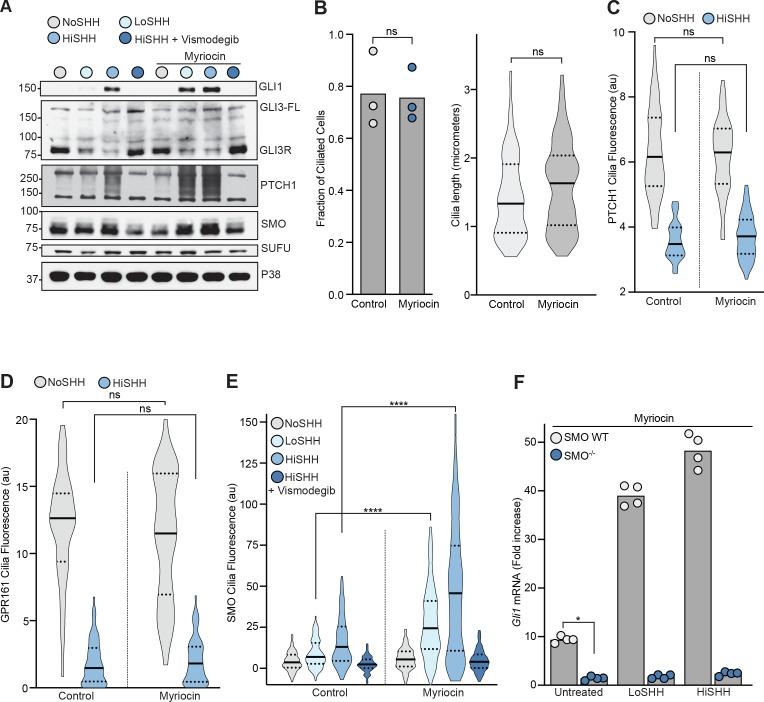
The effect of myriocin treatment on the abundances of hedgehog pathway components and on ciliary protein trafficking.(A) Western Blot showing levels of HH signaling proteins (SMO, SUFU and GLI3-FL/GLI3R) and HH target genes (GLI1 and PTCH1) after treatment with myriocin and either LoSHH (2.5 nM), HiSHH (25 nM) or HiSHH with Vismodegib (2.5 µM). (B) Ciliation frequency (left) of cells after myriocin treatment, calculated as the number of cilia over the number of nuclei. Each point represents the ciliation frequency (derived from >30 cells) in a different imaging field. The cilia length distribution (from 100 cells) is shown on the right. (C and D) Violin plots showing the lack of an effect of myriocin on levels of PTCH1 (C, n > 50 cilia per condition) or GPR161-YFP (D, n > 35 cilia per condition) at cilia by quantitative fluorescence microscopy in the absence or presence of HiSHH (25 nM). (E) Violin plots showing the SHH-induced ciliary accumulation of endogenous SMO in the presence and absence of myriocin (n > 100 cilia per condition, SHH concentrations as in A). (F) HH signaling triggered by myriocin alone or myriocin in combination with LoSHH (5 nM) or HiSHH (50 nM) in Smo-/- MEFs or Smo-/- MEFs stably expressing wild-type SMO. Bars denote the mean value derived from the four individual measurements shown. Statistical significance was determined by the Mann-Whitney test (B–F); p-values are: (B) p-value>0.9999 for fraction of ciliated cells and p-value=0.0603 for cilia length, (C) p-value=0.7581 for NoSHH and p-value=0.7801 for HiSHH, (D) p-value=0.5469 for NoSHH and p-value=0.5604 for HiSHH, (E) p-value<0.0001 (both comparisons), and (F) p-value=0.0286.